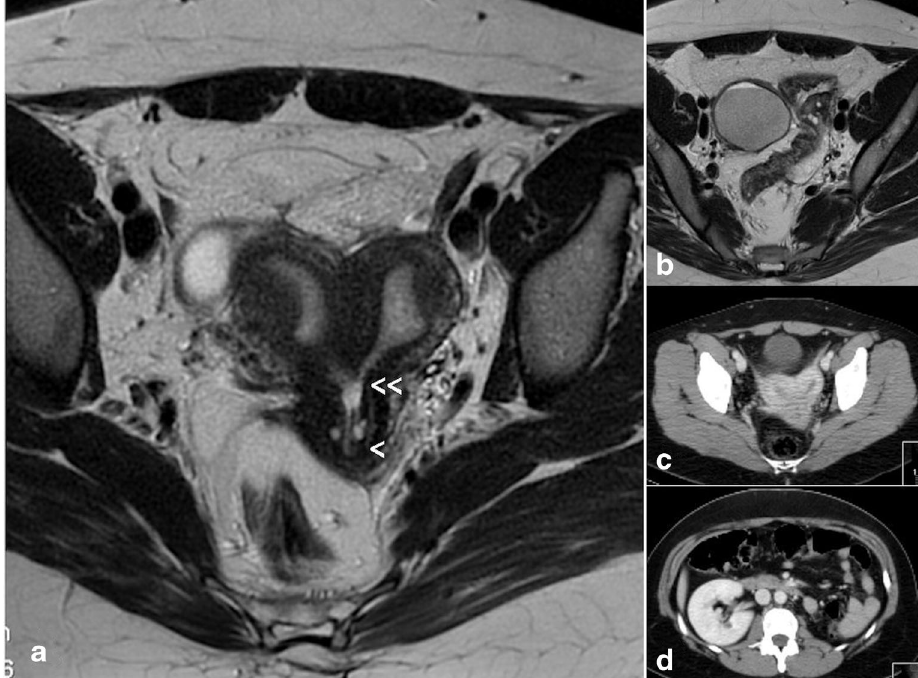
Fig. 4 Patient (32 years old) with complete unilateral vaginal or cervicovaginal agenesis or atresia and huge endometrioma. a T2- weighted MR image showing a bicornuate (transitional or bicorporeal septate) uterus with communication at the ithsmic level (<<), septate cervix (very thin) with left cervicovaginal atresia (<). At the examinationshe had only a cervical external os (right side) and also severe endometriosis with great right endometrioma (shown in B). b Right endometrioma. c CT